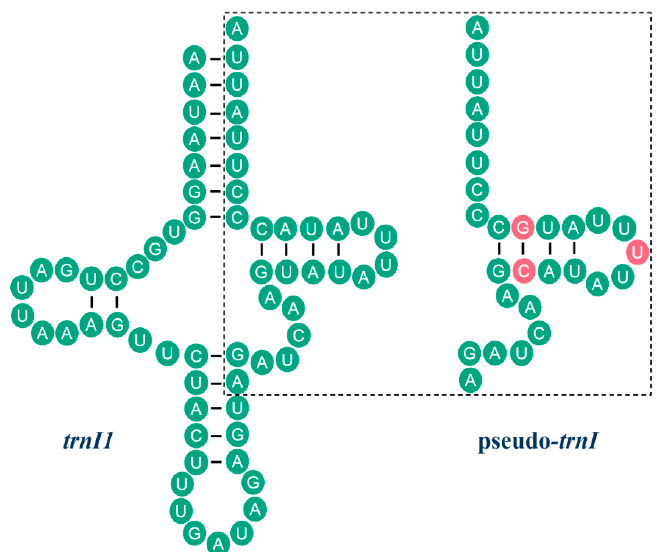
Figure 4. The secondary stem-loop structure and sequence similarity of trnI1 and pseudo- trnI . Inferred Watson-Crick bonds are illustrated by lines, whereas GU bonds are illustrated by dots. The identical nucleotides between trnI1 and pseudo- trnI are labeled with green circles. The sequences in the dotted box represent the homologous sequences between trnI1 and pseudo- trnI . The variable sites are in red.